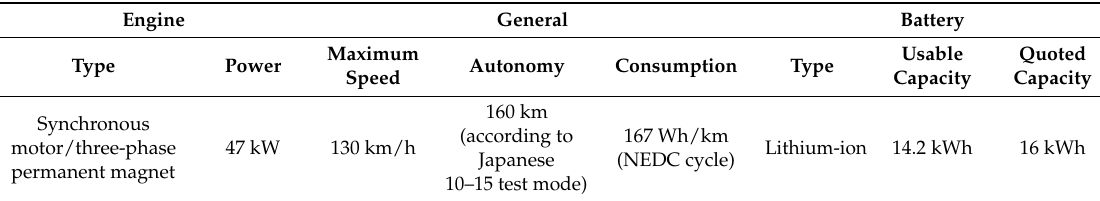
Table 2. Vehicle and battery characteristics. NEDC: New European Driving